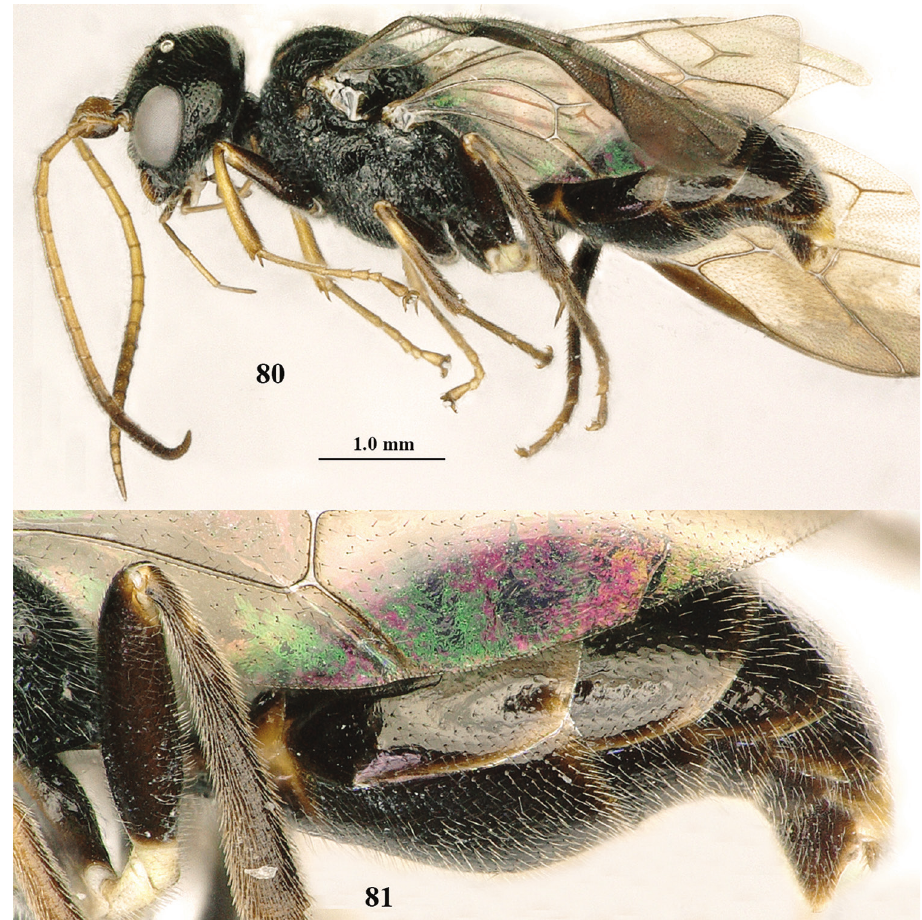
Figures 80, 81. Taeniogonalos alticola (Tsuneki), female, Ningxia (Liupan Mt.). 80 habitus lateral 81 metasomal